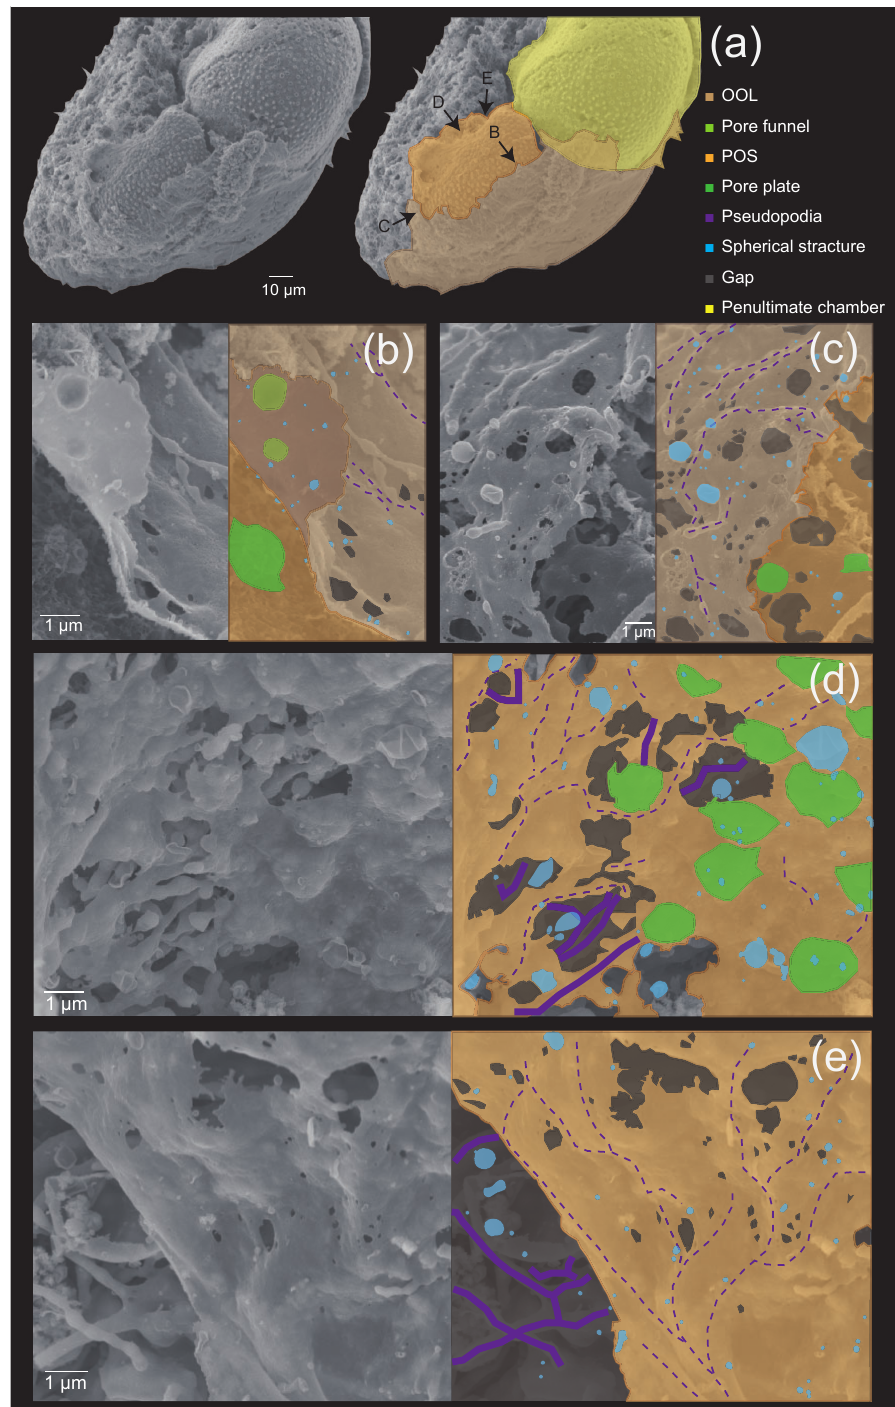
Figure 3. Microstructures during the initial stage of the chamber formation, shown by SEM images on the left, supplemented by schematic explanation on the right. (a) Overview of a specimen showing the OOL covering both the newly forming and older chambers. (b–c) Mag- nified images showing the OOL and the POS. (d–e) Magnified image of the POS construction front showing the weaving action of pseu- dopodia. (e) The same POS construction front showing the membranous pseudopodia extending so as to close a large hole (white arrow). Colour legend: brown = OOL; orange = POS; purple = pseudopodia/cytoplasm; light green = pore funnel on the OOL; green = pore plate; blue = spherical structures; gray = gap. Thick lines indicate membranous pseudopodia and dotted lines indicate framework